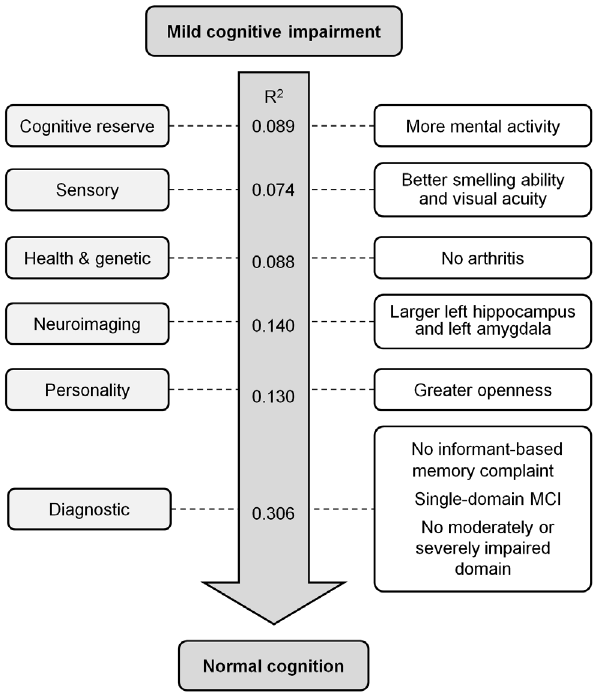
Figure 2. Baseline factors associated with reversion from mild cognitive impairment to normal cognitive functioning. Univar- iate analyses identified measures that discriminated between reverters and non-reverters. Each of these measures was assigned to one of six sets of related variables: cognitive reserve, sensory, health and genetic, neuroimaging, personality, and diagnostic. For each of these sets we performed a separate multivariable regression containing the discrim- inating measures assigned to that set, controlling for age and sex (and intracranial volume for the neuroimaging set). A separate Nagelkerke R2 value is shown for each of the six sets. The factors on the right hand side are those from among the variables in the relevant set that were independently associated with reversion (p , 0.05).